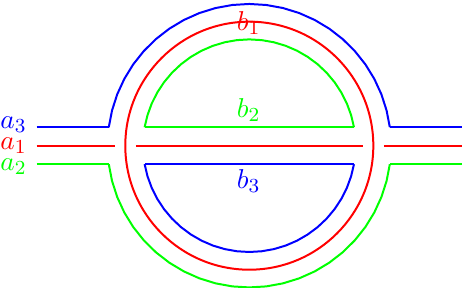
Figure 4 . The two-loop supergraph contributing to the self-energy (cid:6) a 1 a 2 a 3 drawn in triple-line